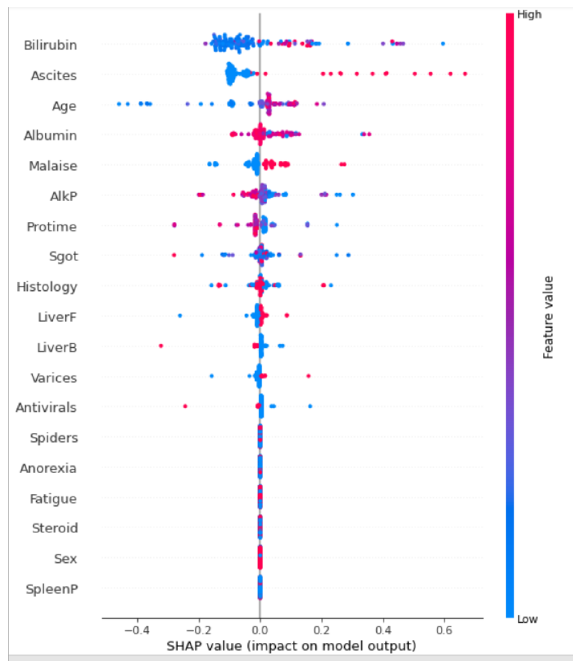
Figure 3. Summary plot of the